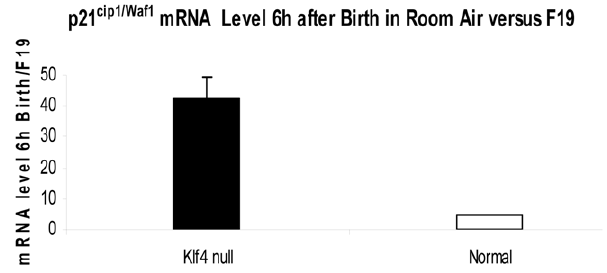
Figure 10. Induction of p21 cip1/Waf1 messenger RNA and protein in Klf4 null lung versus normal lung at birth. The content of p21 cip1/Waf1 mRNA increased 38-fold in Klf4 knockout lung between day 19 of gestation and 6 h after birth, but only 5-fold in normal lung.